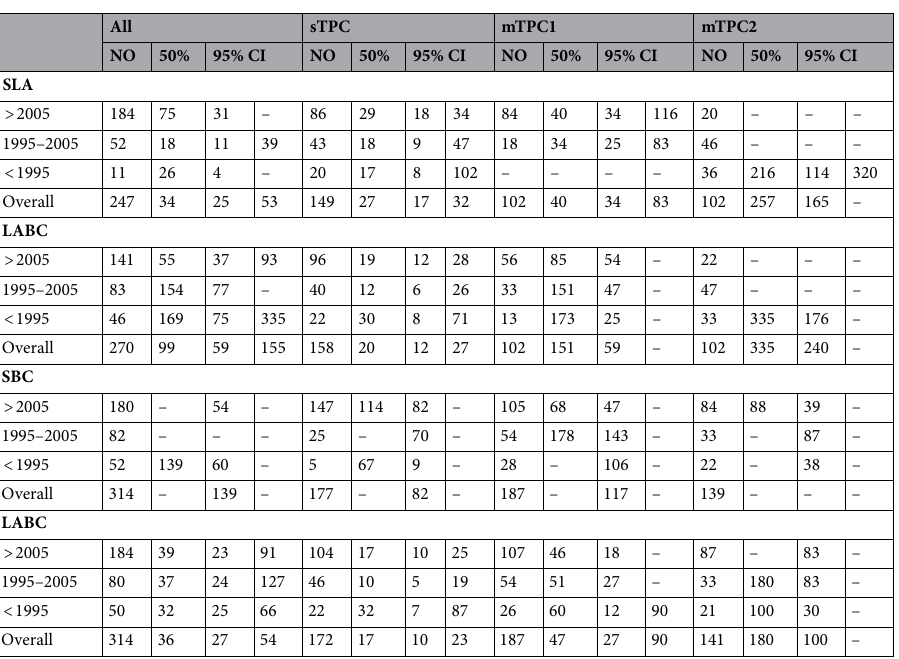
Table 3. Overall-survival analysis between patients with LABC and matched single breast/lung cancer. LABC breast cancer with prior primary lung cancer; SBC Single breast cancer; SLA Single lung cancer, – not reached; Overall survival was determined by median survival time